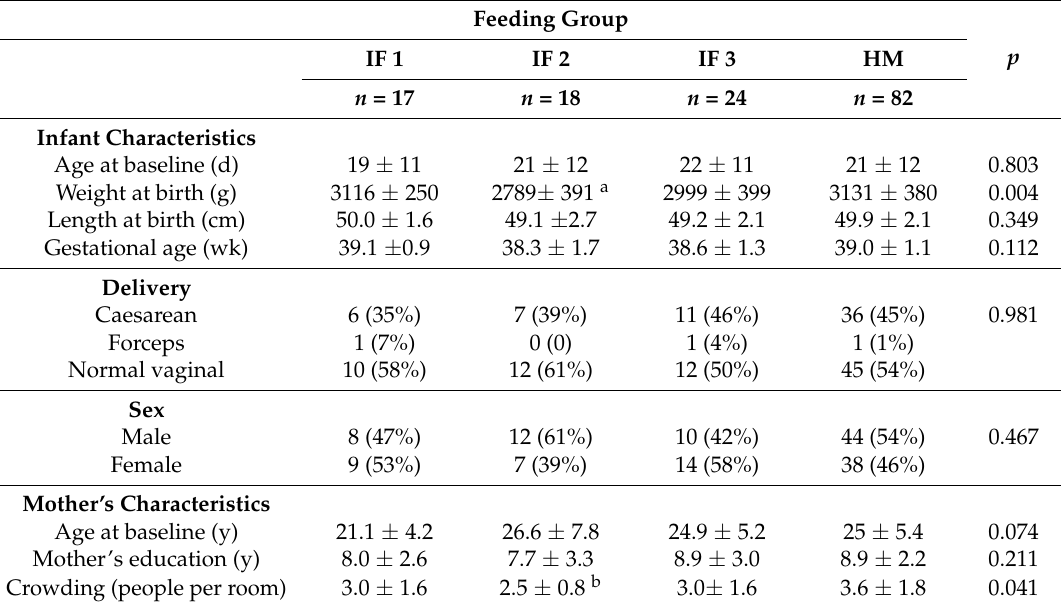
Table 3. Baseline characteristics of the participants who completed the study.